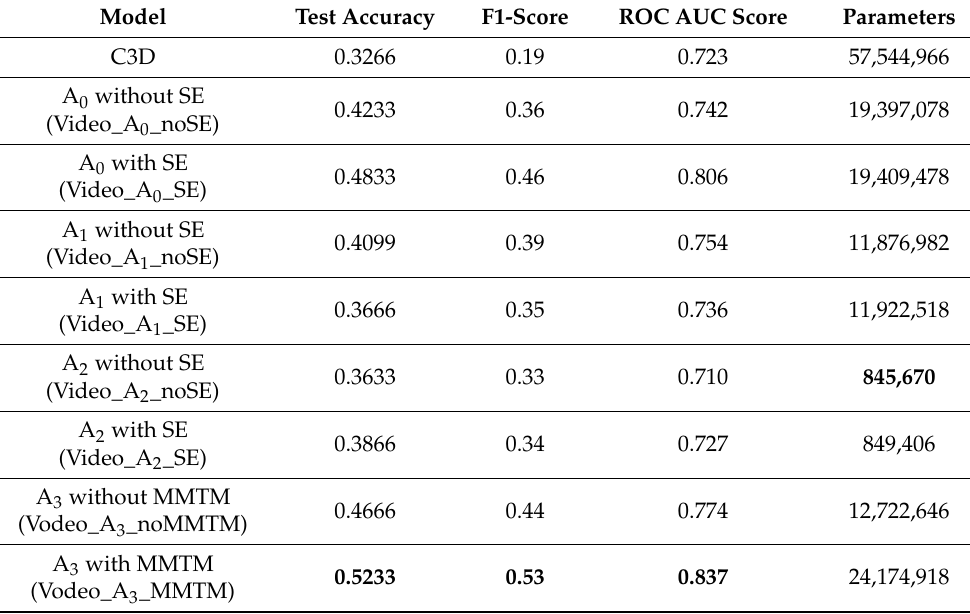
Table 4. Test results using video